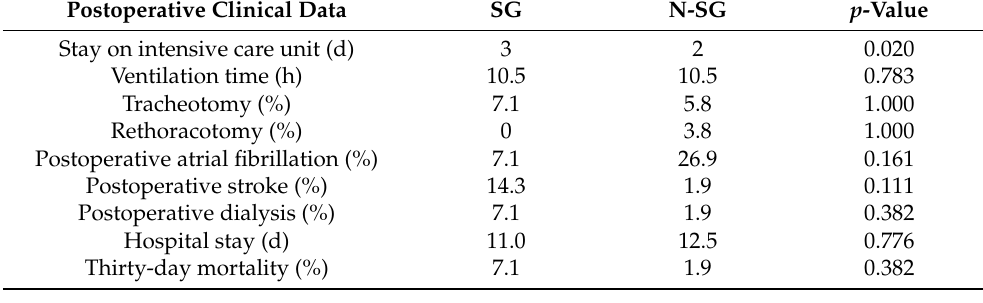
Table 7. Postoperative clinical data.